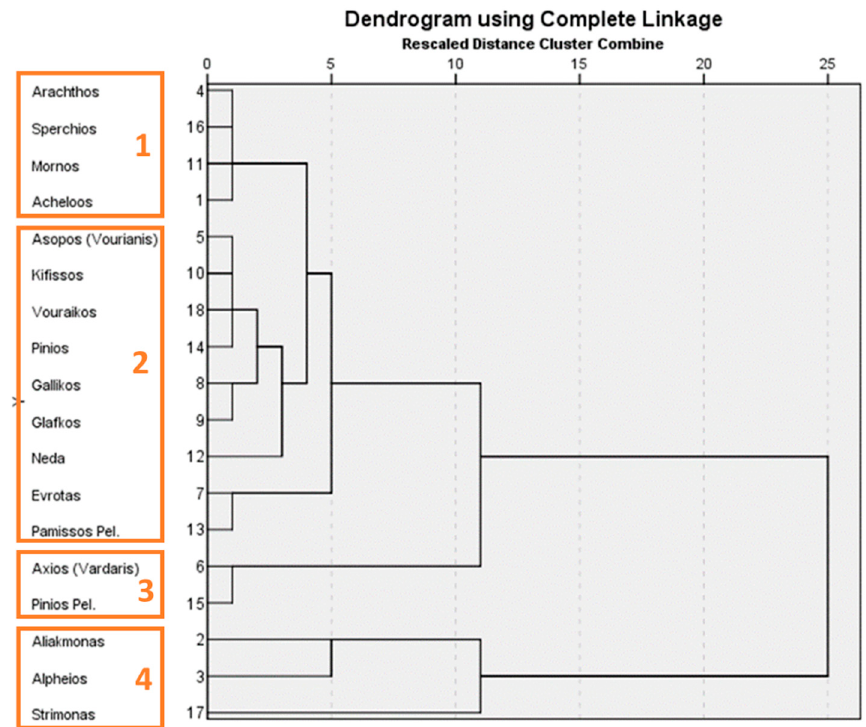
Figure 9. Groups of rivers derived by the cluster analysis based on the average nutrient loads that they receive.